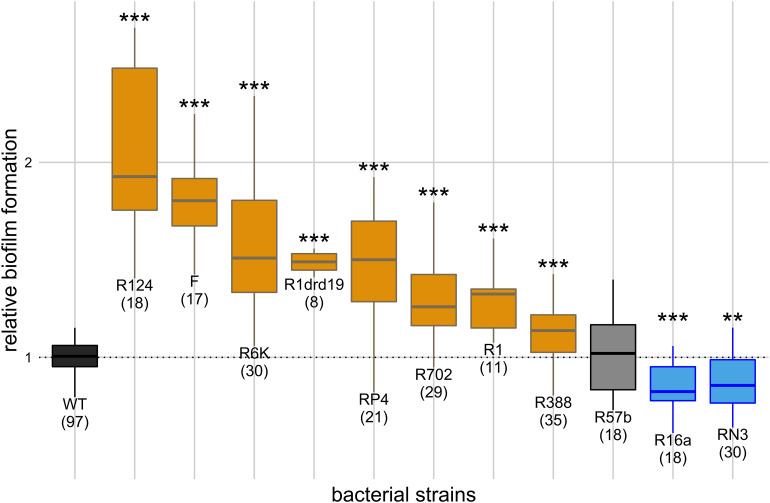
Effect of single plasmids on biofilm formation. Y axis represents biofilm formation relative to the plasmid-free strain (WT). Annotations under the boxes indicate the identity of the plasmids and, in parenthesis, the number of biological replicates. Results of Dunnett’s multiple comparison test against the plasmid-free strain are indicated above the boxes as: **p-value < 0.01; ***p-value < 0.001. Box color indicates the phenotype qualitatively, such that biofilm formation: increased significantly (orange), decreased significantly (blue), or did not change significantly (light gray). Dark gray indicates the plasmid-free reference strain (WT).